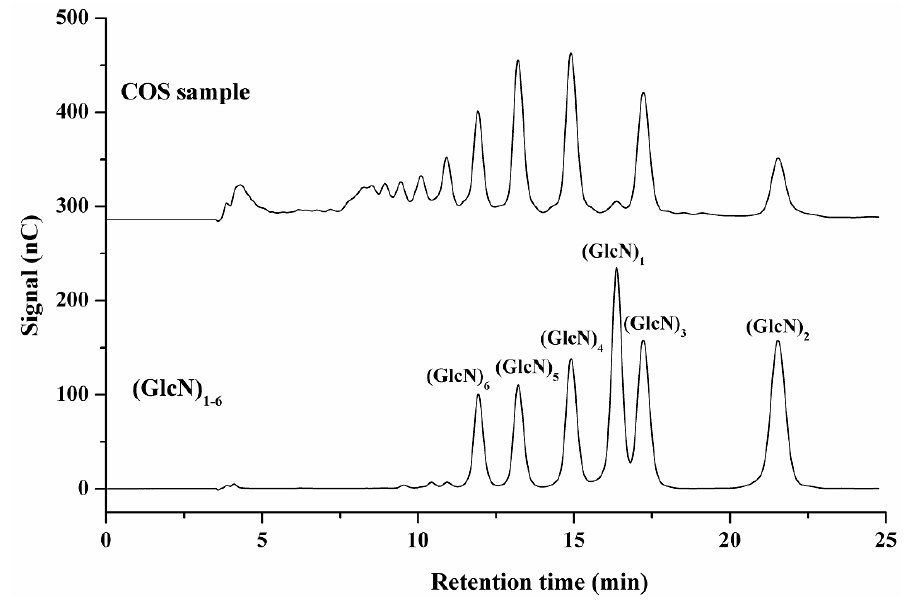
Figure 2. HPAEC-PAD chromatograms of COS technical concentrate and (GlcN) 1–6 standards.